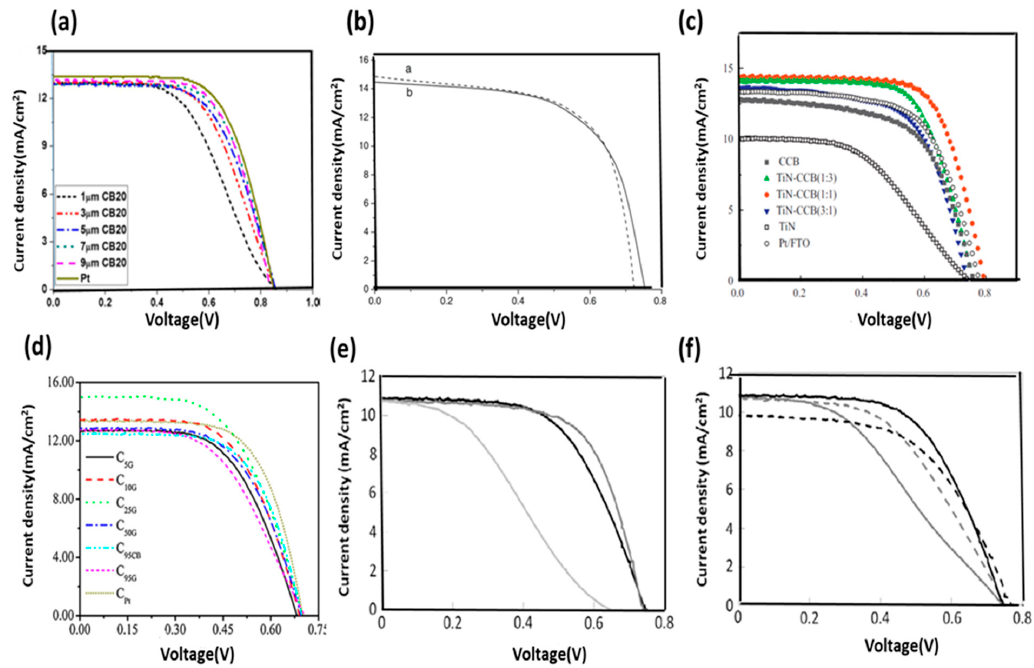
Figure 9. Characteristic J–V curves of hybrid carbon materials: ( a ) CB, ( b ) [CB + Pt], ( c ) [CB + TiN], ( d